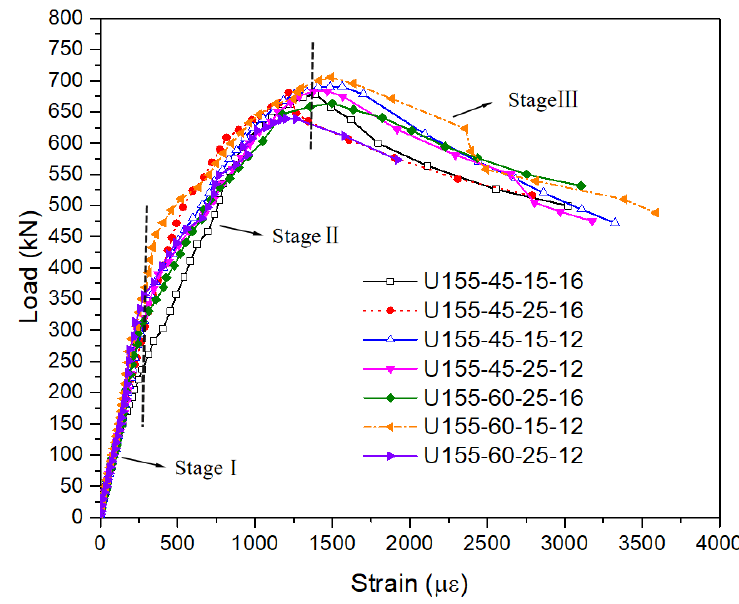
Figure 14. Load- strain of UHPFRC surface curves.